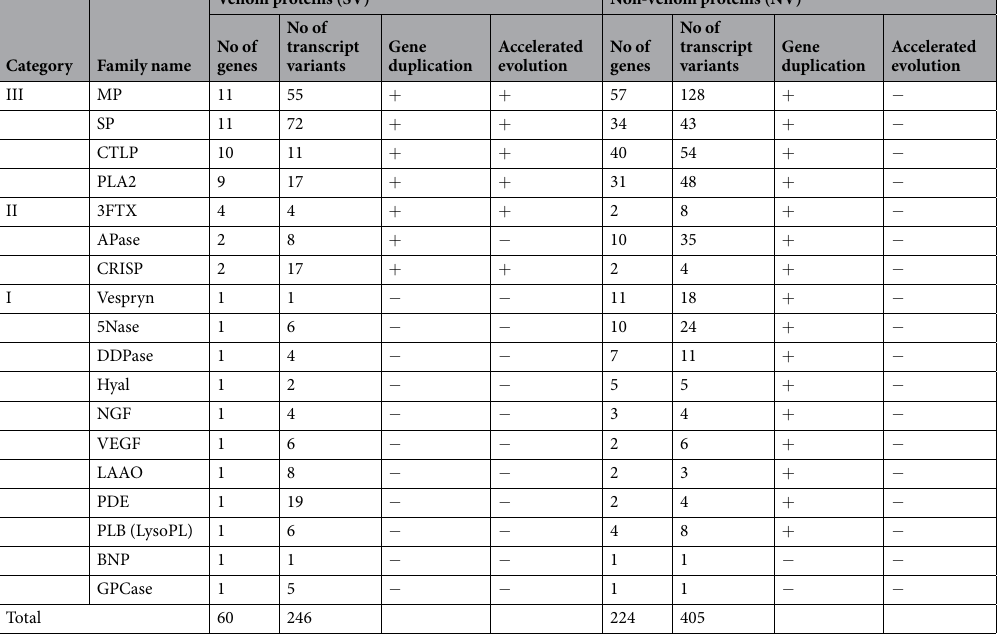
To establish clear relationships of SV and NV genes within given families, molecular phylogeny was conducted in each family. These results showed that all habu SV genes of a given family clustered with SV homologs of the same family from species in the Viperidae, such as P . mucrosquamatus (Brown spotted pitviper) and Ovophis okinavensis (Himehabu), and in the Elapidae, such as O . hannah (King cobra). On the other hand, habu NV genes